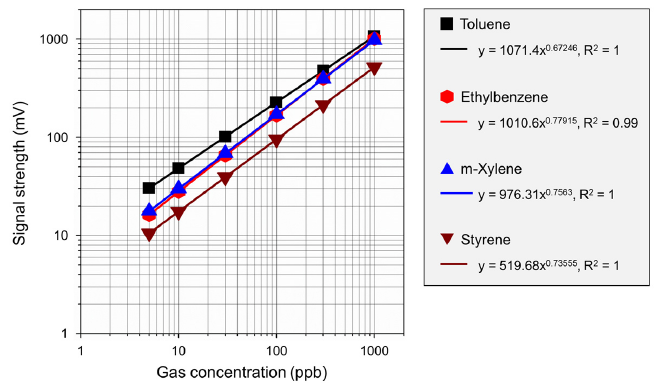
Figure 6. Calibration curve of VOCs (Toluene, Ethylbenzene, m-Xylene and Styrene).